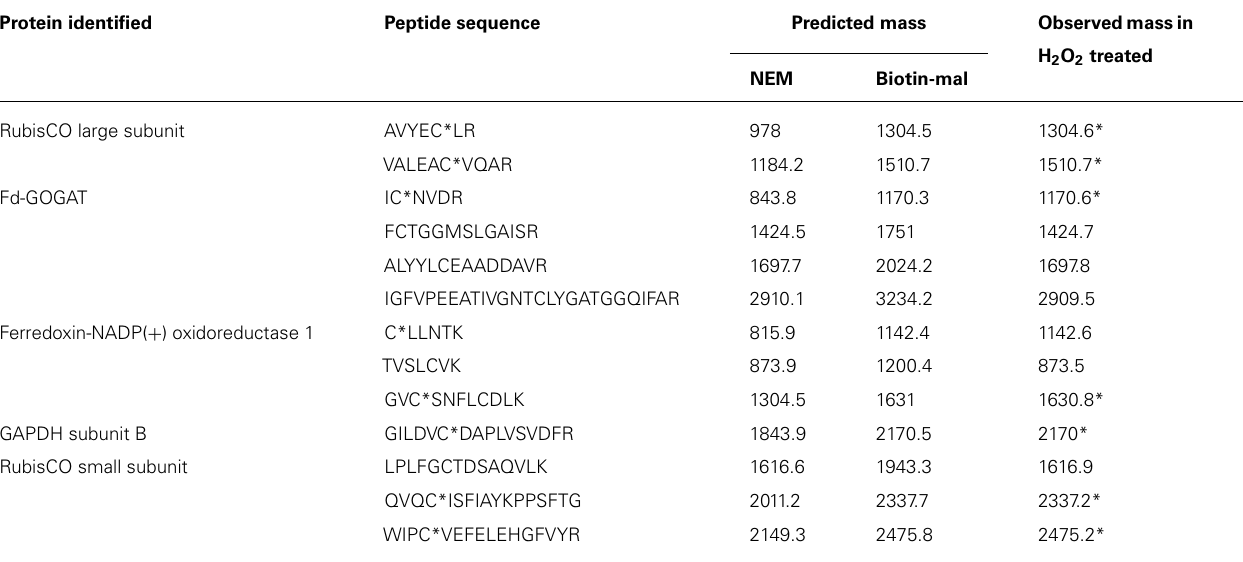
Table 2 | Identification of cysteines modified upon